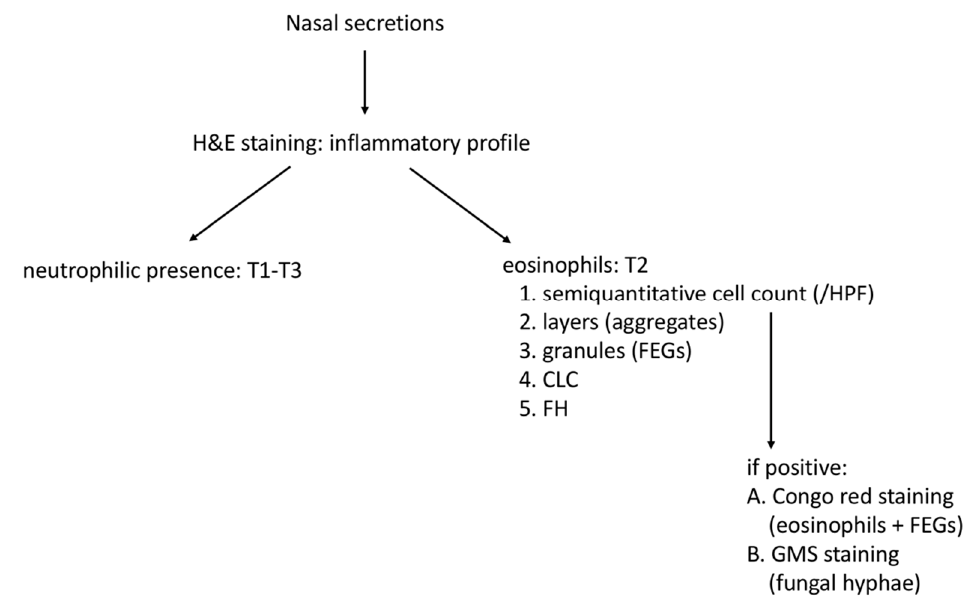
Figure 4. Proposal for structured histopathology of nasal secretions for endotyping